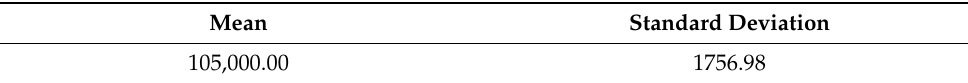
Table 3. The mean and the standard deviation of the optimized portfolio obtained with 10,000 out-of-sample